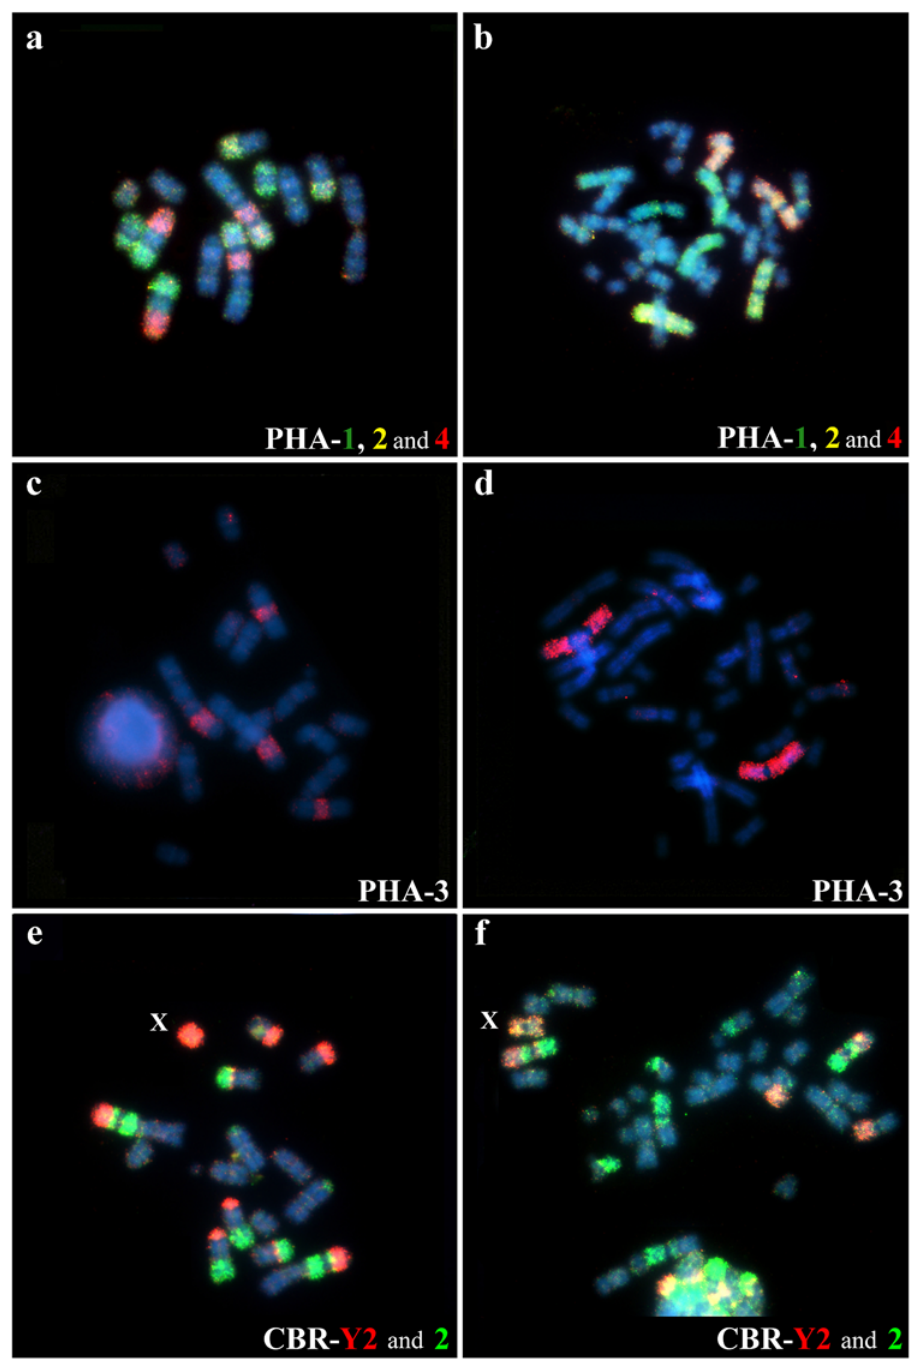
Fig 3. Chromosomal painting in Tonatia saurophila (a, c and e), Phyllostomus discolor (b) and Lophostoma silvicola (d and f), using PHA (above and middle) and CBR probes (below).